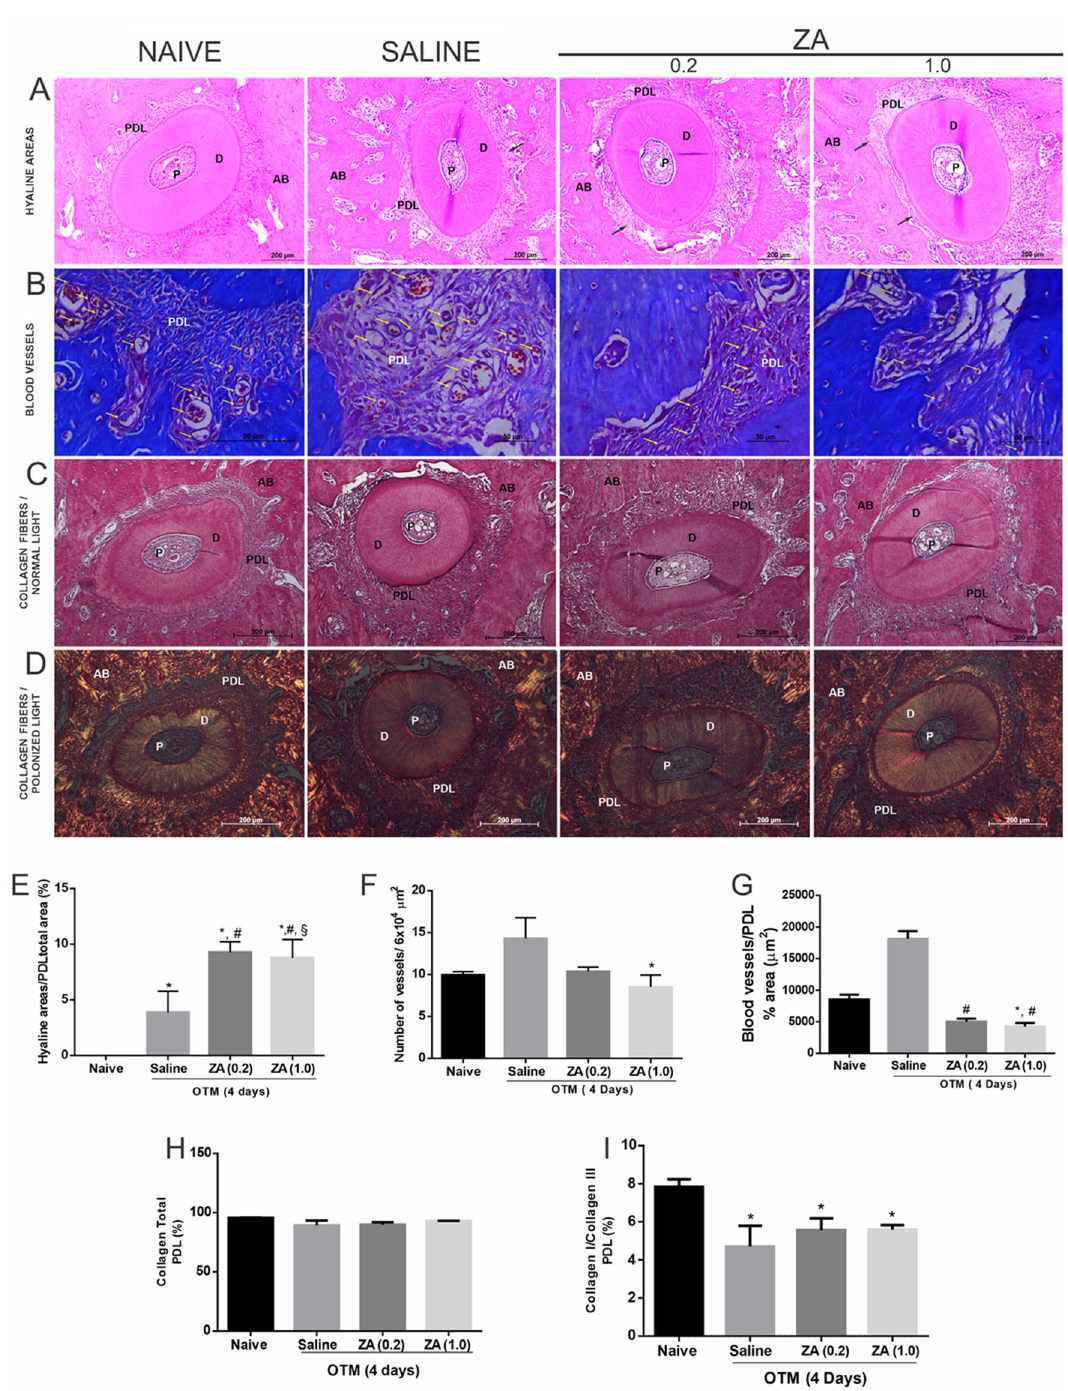
Figure 4. Effect of zoledronic acid on the periodontal ligament in the experimental groups Naive, Saline, ZA (0.2) and ZA (1.0). (A) Cross section of the root DV in HE staining (B) Mallory staining, × 400 magnitude, the bars indicate 50 µm (C) staining with HE and (D) picrosirius under polarized light. AB bone alevolar, D dentin, PDL periodontal ligament, P pulp. (E) Histomorphometry of the periodontal ligament area with analysis in relation to the total area of the PDL. Bars represent mean ± SEM of (n = 6/group). (*) indicates difference when compared to the Naive group. (#) indicates difference when compared to the Salina group. (§) indicates difference when compared to the ZA group (0.2) (ANOVA p < 0.001, Levene p = 0.043 and Tukey pos-hoc test). (F) Analysis of the mean by fields of the amount of blood vessels. Bars represent mean ± SEM of 6 animals per group. (*) indicates difference when compared to the Salina Group (kruskal Wallis test p = 0.015 and Dunn’s pos-hoc test). (G) Analysis of the blood vessel area on the tension side of the PDL in the experimental groups. Bars represent mean ± SEM of 6 animals per group. (*) indicates difference when compared to the Naive Group and (#) indicates difference when compared to the saline group (kruskal Wallis test p < 0.001 and Dunn’s pos-hoc test). (H, I) Histopathological analysis of the type I / type III collagen fibers ratio. Kruskal–Wallis test followed by Dunn’s